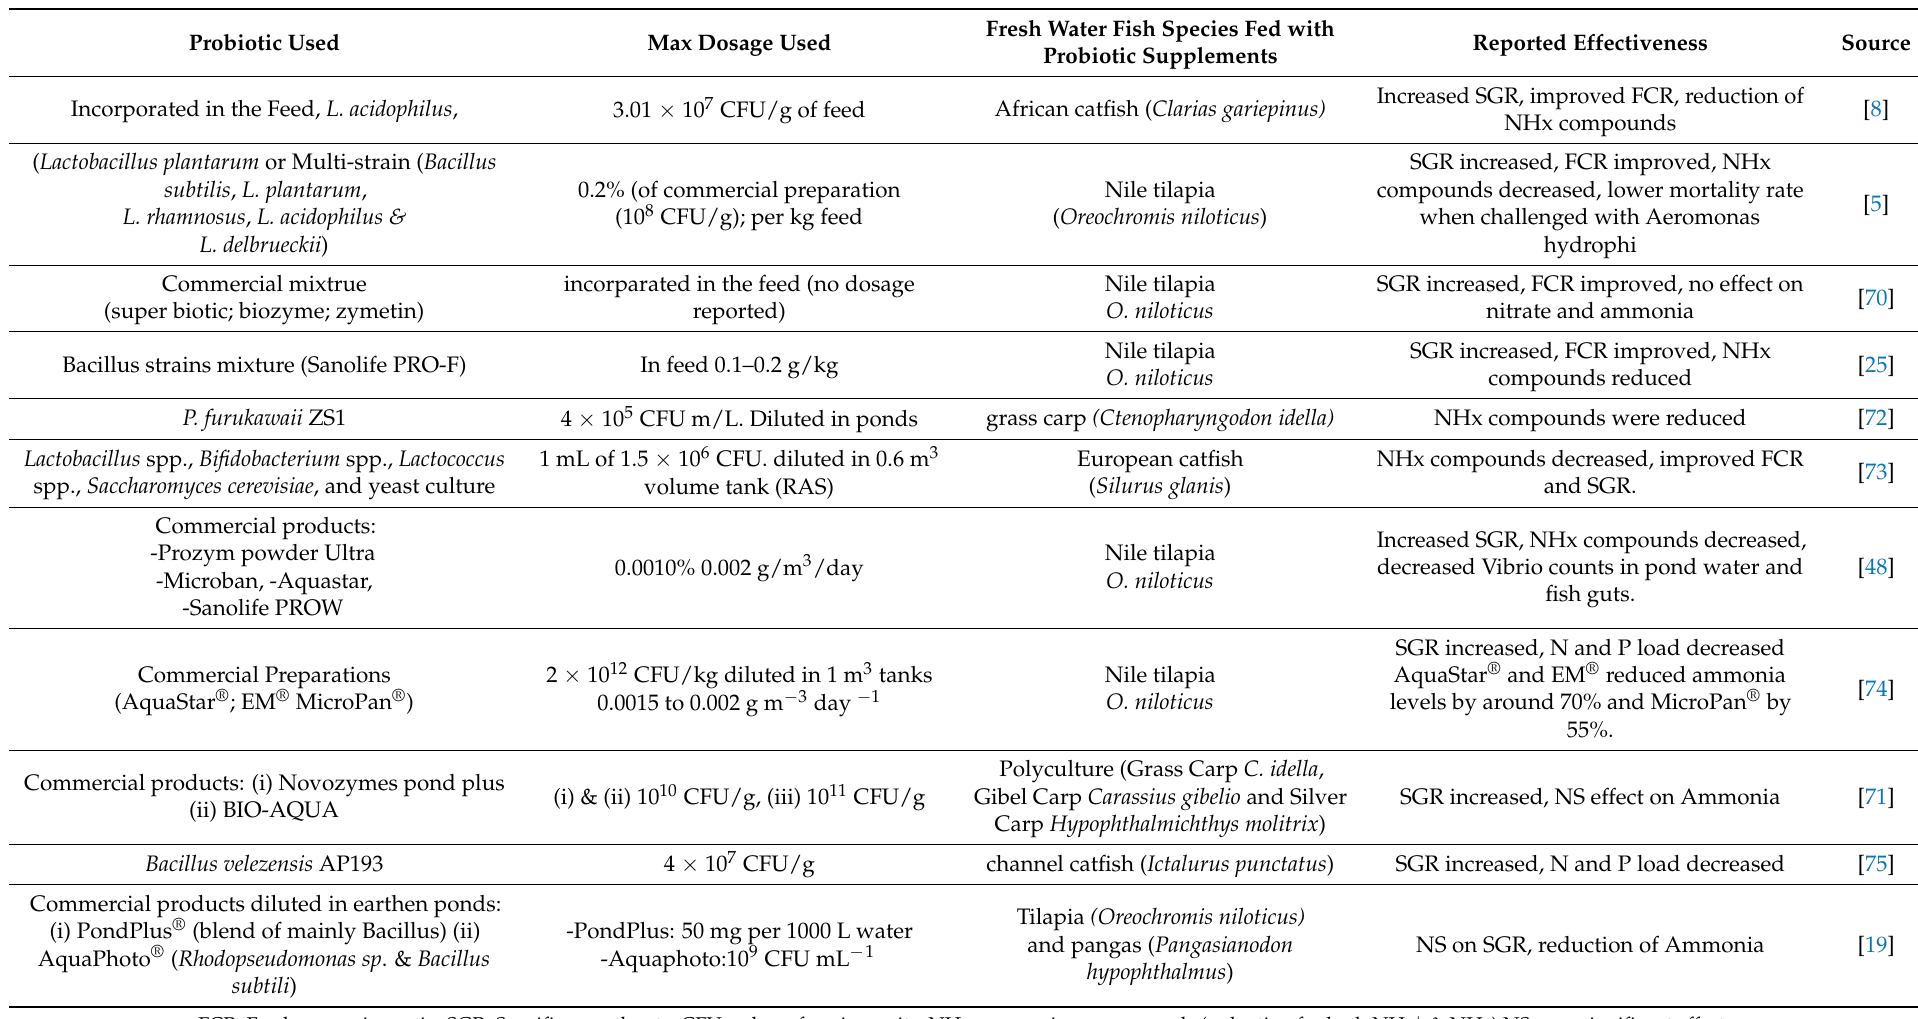
Table 1. Examples of papers ( n = 11) reporting the effects of probiotics on growth and water quality parameters of cultivated freshwater fish species over the last 10 years. Probiotic Used Incorporated in the Feed, L. acidophilus